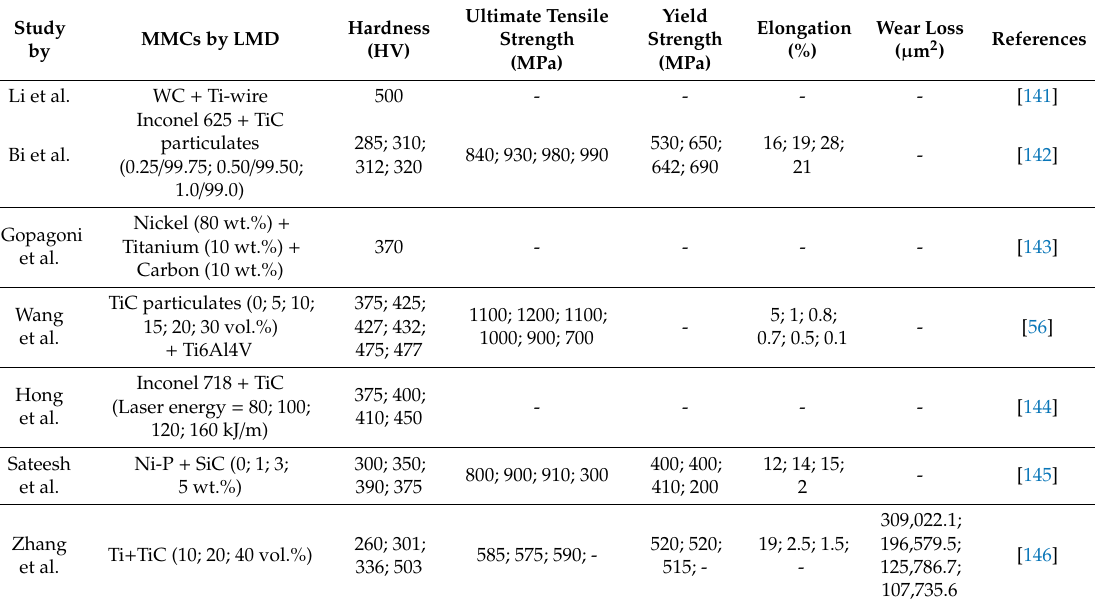
Table 7. Summary of MMCs mechanical